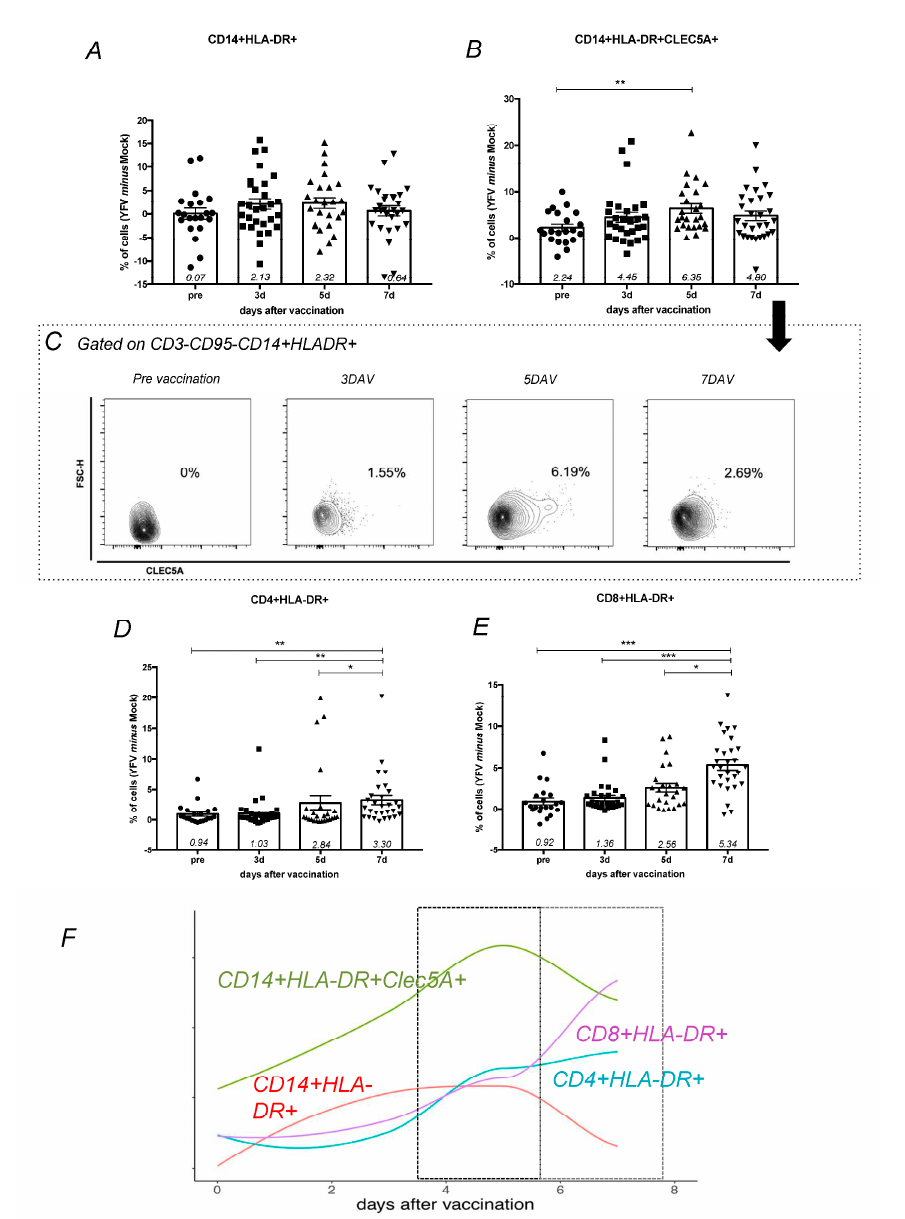
Figure 1. Phenotypes of monocytes and T lymphocytes during vaccination follow-up. Peripheral blood mononuclear cells (PBMCs) from vaccinated volunteers ( n = 38, 15 first time vaccinated and 23 s time vaccinated) were stimulated for 24 h with YF17DD in vitro. Bar-graphs show the cell population frequencies of ( A ) activated monocytes, represented as CD3 − CD95 − CD14 + HLA-DR + , and ( B ) activated monocytes expressing CLEC5A, represented as CD3 − CD95 − CD14 + HLA-DR + CLEC5A + . Cell population frequencies were calculated by frequency in YF17DD stimulated experimental condition minus frequency in unstimulated (mock) experimental condition. ( C ) Cells from one subject are represented as a density plot (FlowJo Tree Star ® ) showing the kinetics of CLEC5A expression on activated monocytes. ( D ) Activated CD4 + T cells are represented as CD3 + CD95 − CD4 + HLA-DR + . ( E ) Activated CD8 + T cells are represented as CD3 + CD95 − CD4 − HLA-DR + . Cell population frequencies were compared between time points using Kruskal–Wallis with Dunns post-test, with significant p value represented as * p < 0.05, ** p < 0.01, *** p < 0.001. Each point corresponds to one individual analyzed, with median and standard error of groups. ( F ) Graphic representation of cellular phenotypes during vaccination follow-up. Lines represent these percentage difference distributions over time for CD14 + HLA-DR + CLEC5A + (green), CD14 + HLA-DR + (red), CD8 + HLA-DR + (purple), and CD4 + HLA-DR + (turquoise).